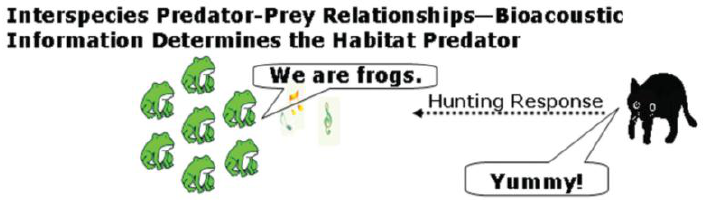
Figure 8. Predator-prey relationship. Copyright 2009 Hiroki Kobayashi, with permission from [11].